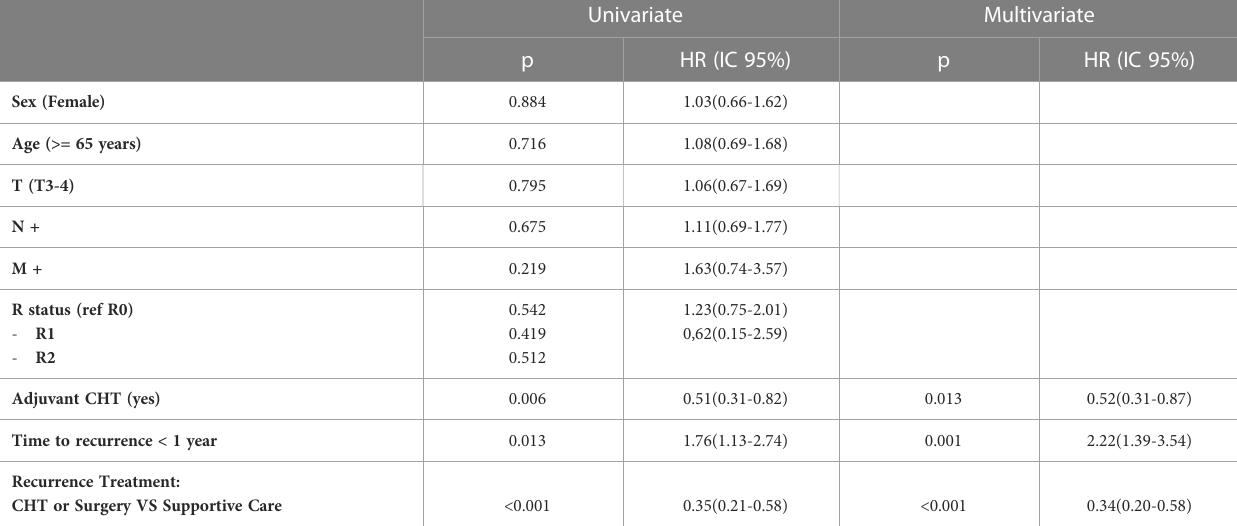
TABLE 3 Univariate and multivariate analysis of risk factors for mortality after cholangiocarcinoma